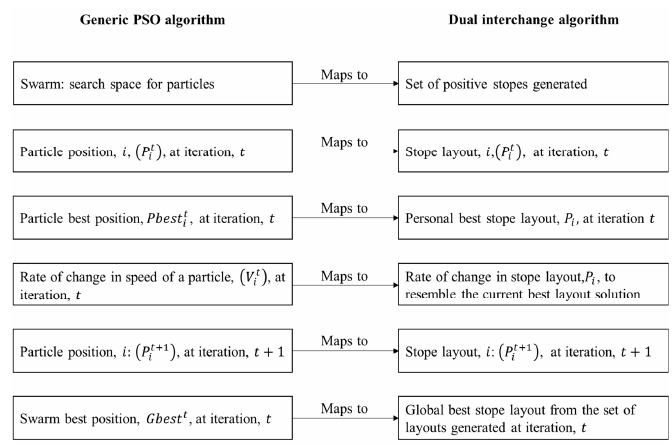
Figure 2. Schematic mapping of the PSO algorithm to DIA.